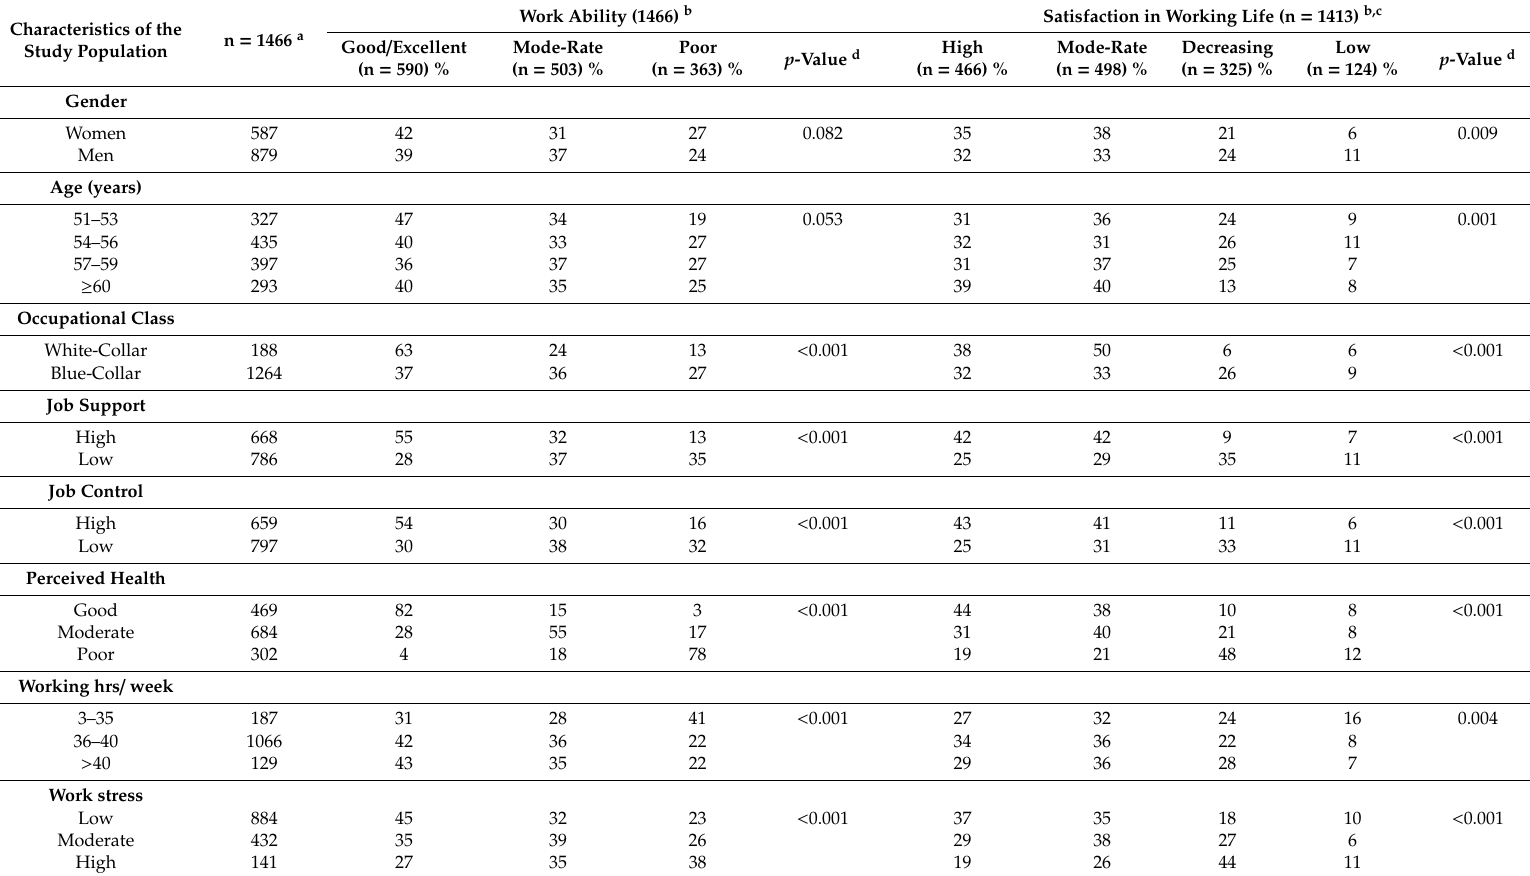
Table 2. Cross tabulation of Basic characteristics of study population and exposure